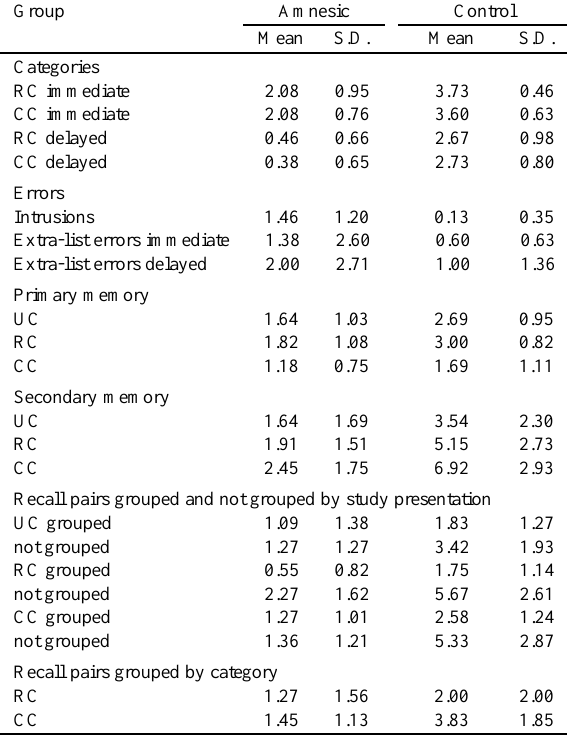
Table 1 Mean scores (and SDs) for category reproduction, errors, and